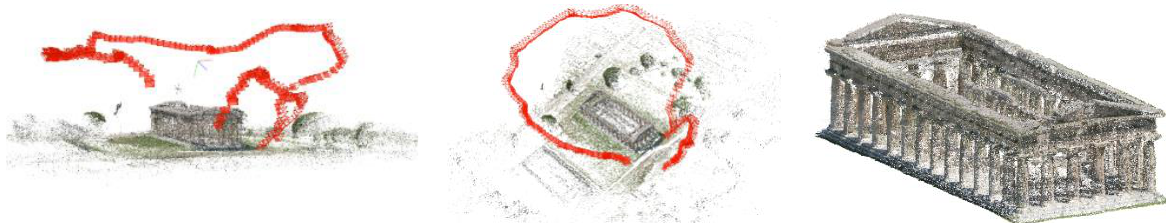
Figure 1. From UAV image network and sparse point cloud (left and middle) to dense point cloud